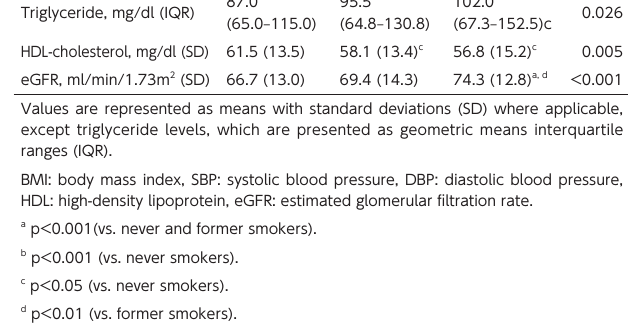
Values are represented as means with standard deviations (SD) where applicable, except triglyceride levels, which are presented as geometric means interquartile ranges (IQR).